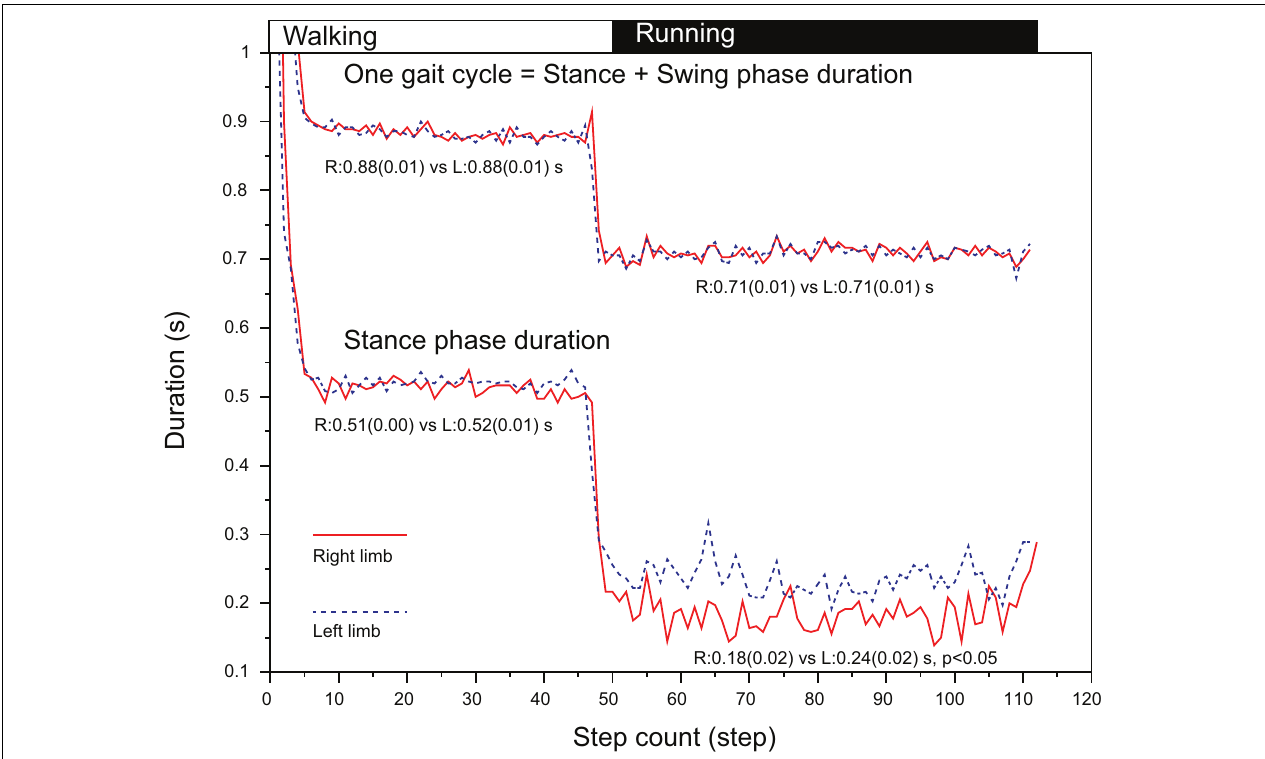
FIGURE 3 | Duration of one gait cycle (HC to HC interval) and stance-phase (HC to TO interval) from an illustrative trial. The stance-phase duration for right leg during running was significantly shorter than that of left leg. HC, heel contact; TO, toe off.